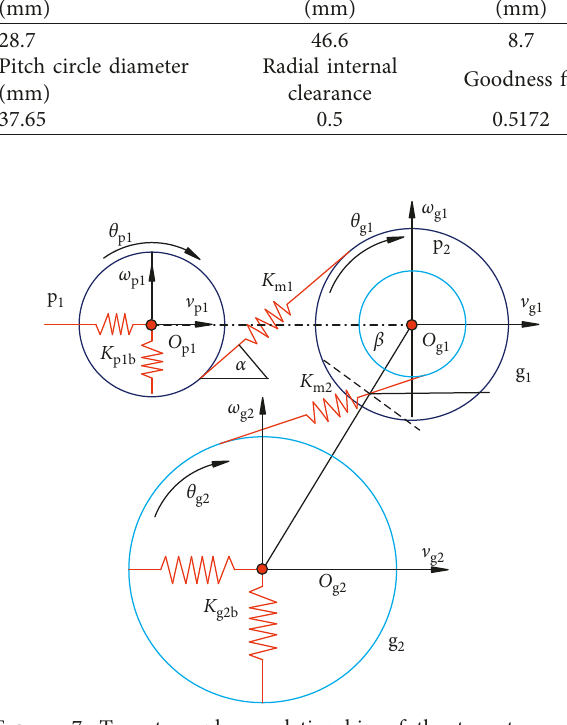
Figure 7: Two-stage phase relationship of the two-stage gear transmission